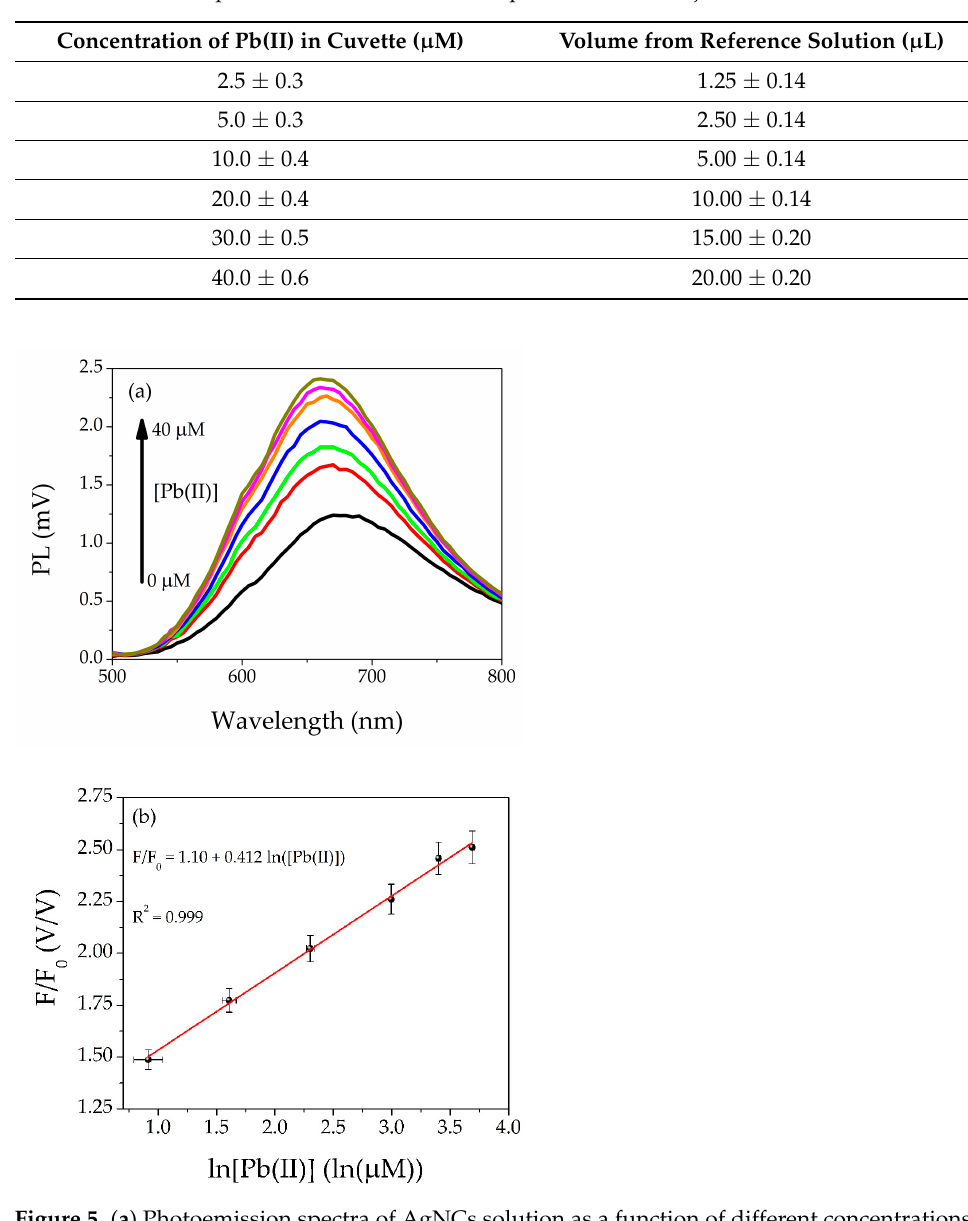
Table 2. Calibration points: concentrations and respective volumes injected from Reference solution.